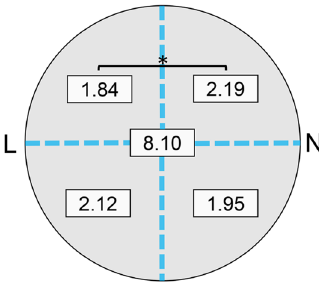
Figure 1. Distribution of number of vortex vein ampullae in four sectors in all subjects. The overall mean number of vortex vein ampullae (VVA) was 8.10/eye and 1.84, 2.12, 2.19 and 1.95 in upper lateral (UL), lower lateral (LL), upper nasal (UN) and lower nasal sector (LN), respectively. A statistically significant difference was observed between UL and UN sectors (* P = 0.012, Wilcoxon signed rank sum test) L lateral side, N nasal side.